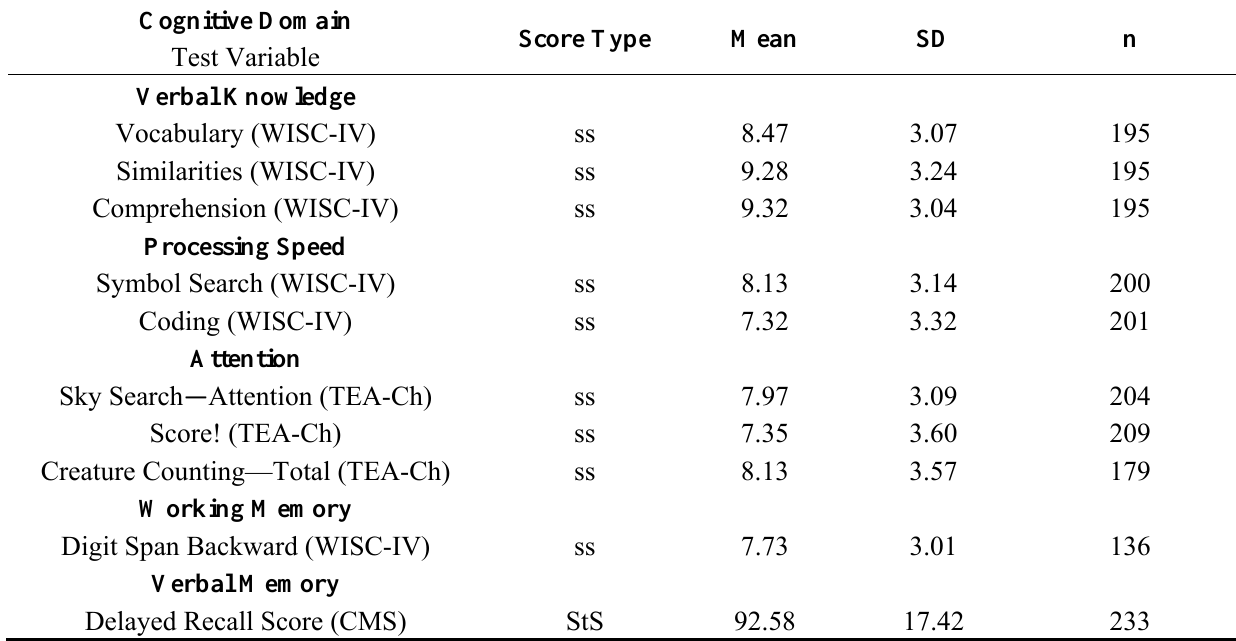
Table 1. Cognitive and verbal memory test performance of